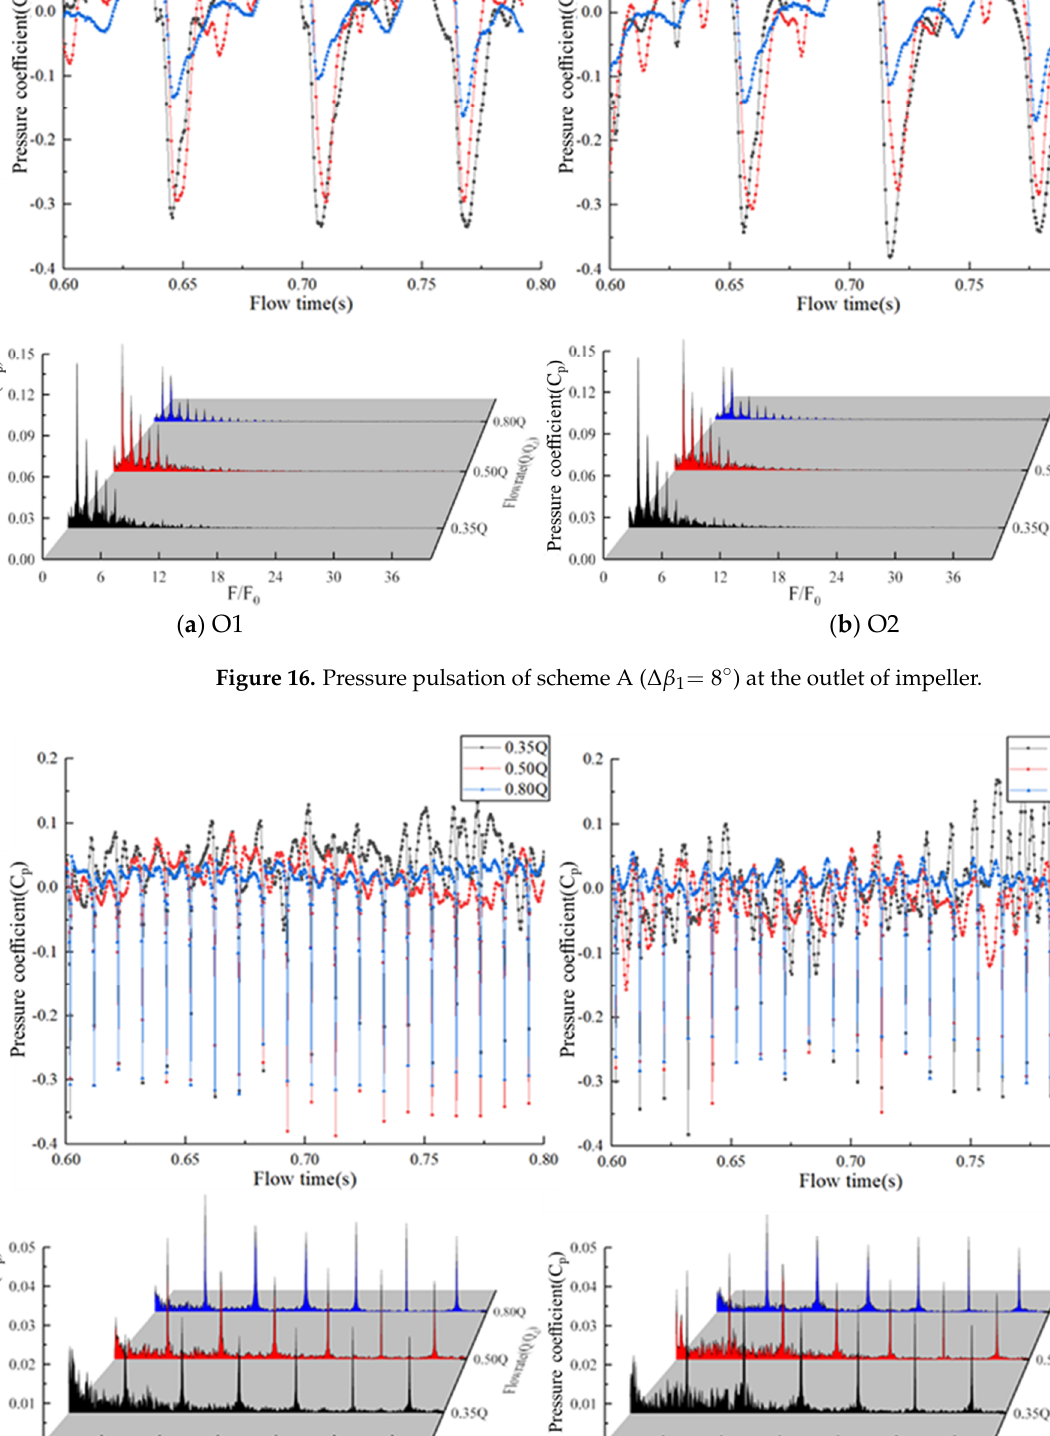
Figure 17. Pressure pulsation of scheme A (